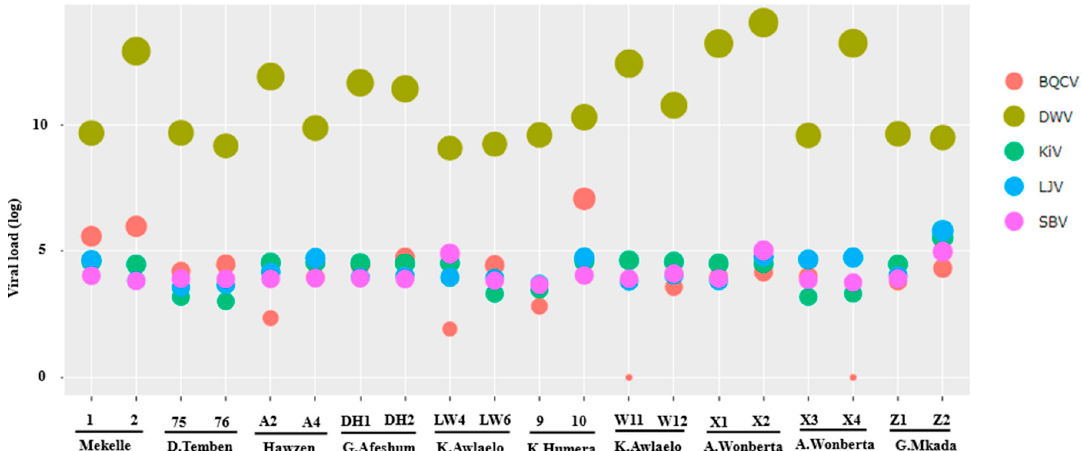
Figure 4. The load of black queen cell virus (BQCV), deformed wing virus (DWV), sacbrood virus (SBV), La Jolla virus (LJV) and Kilifi virus (KiV) per honey bee determined by qPCR. Circle radii indicates the number of virus copy number (log10 + 1 transformed) per bee ( Y -axis). The indication 1 to Z2 refers to the code given to each tested honey bee colony, and district names are given underneath (see Figure